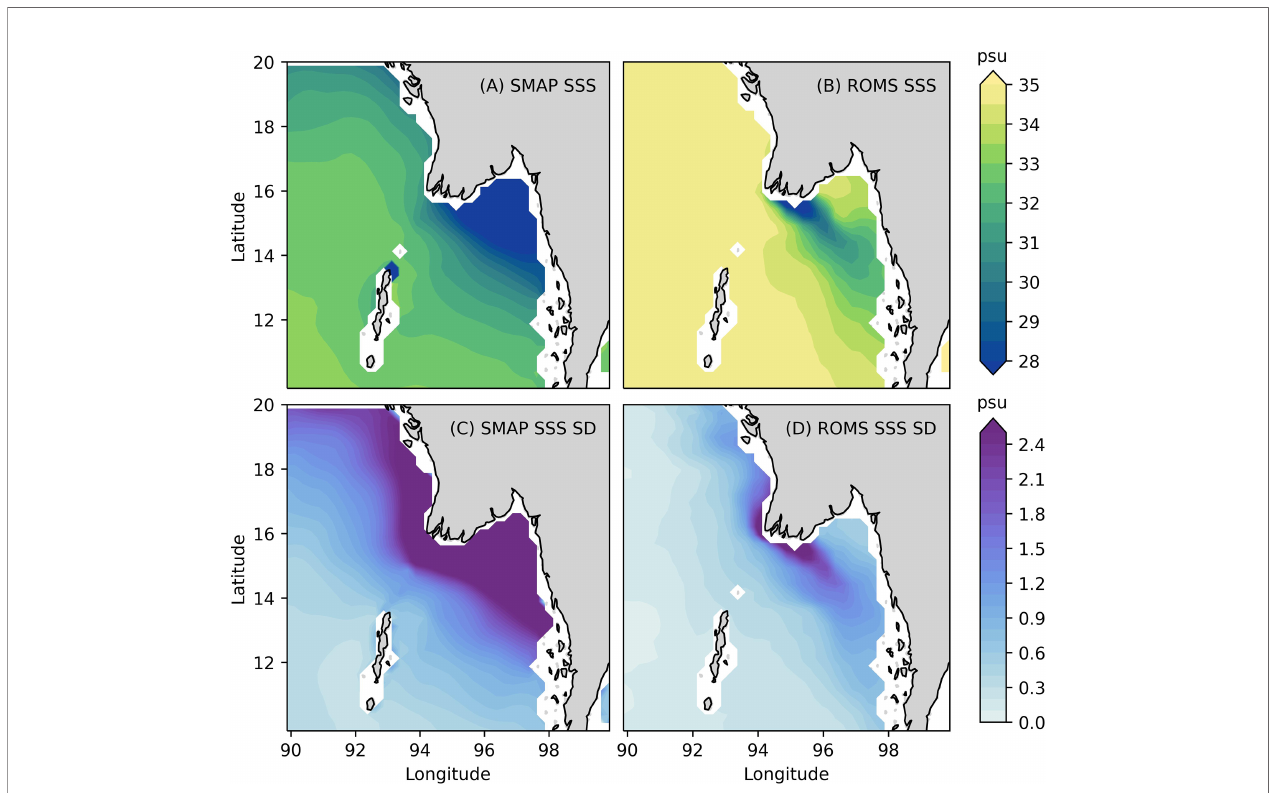
FIGURE 3 | Comparison of SSS climatology from (A) SMAP and (B) model experiment IRfullW for summer monsoon (averaged over June-September). Model climatology is obtained from the last 6 years of experiment IRFullW and then interpolated to the 0.25° resolution grid of the SMAP SSS. SMAP SSS climatology is obtained from the monthly SSS data between January 2016 and December 2021. (C) standard deviation (SD) of SSS from SMAP monthly data obtained for the duration of January 2016 to December 2021. (D) Standard deviation of SSS from the monthly data of the last 6 years of experiment